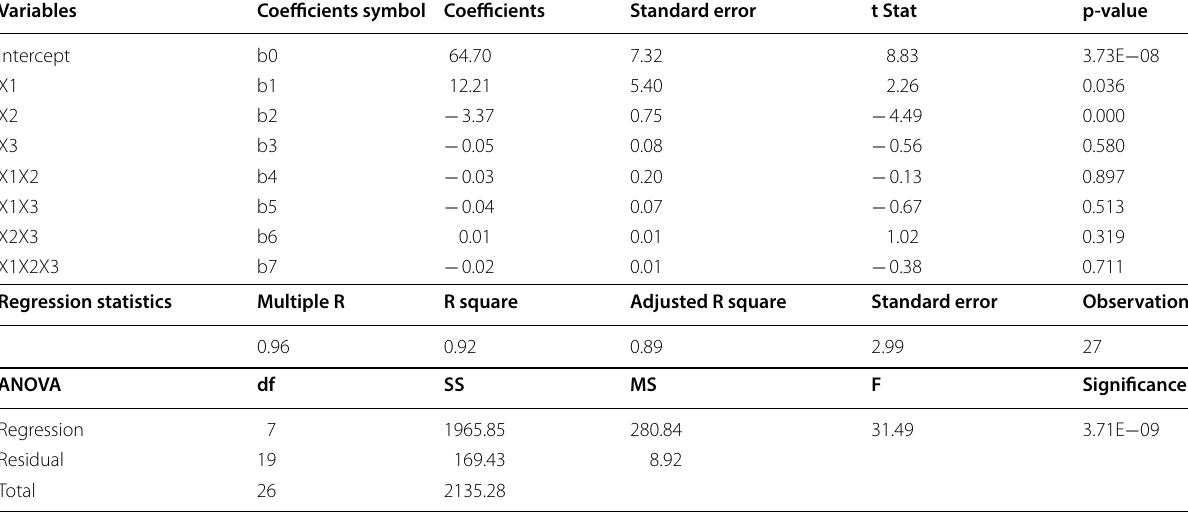
Table 5 The application of regression and ANOVA tests for fluoride removal